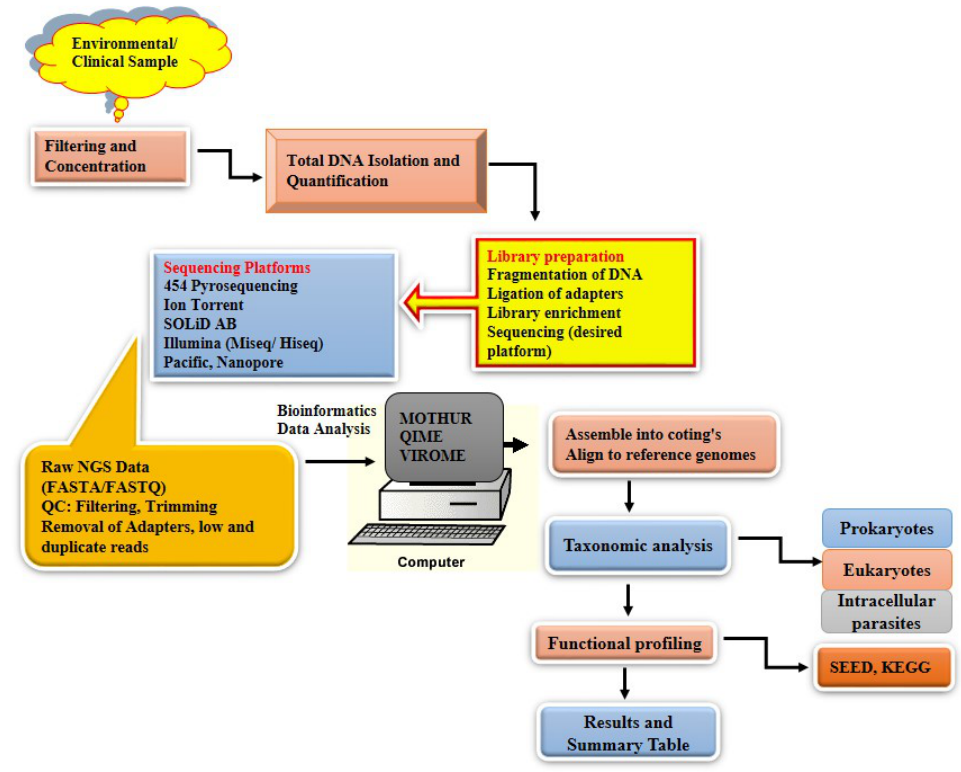
Figure 1. Schematic diagram of the experimental workflow of different next generation sequencing (NGS) platforms. (KEGG—Kyoto Encyclopedia of Genes and Genomes; SEED—Database contains all publicly available genome sequences)